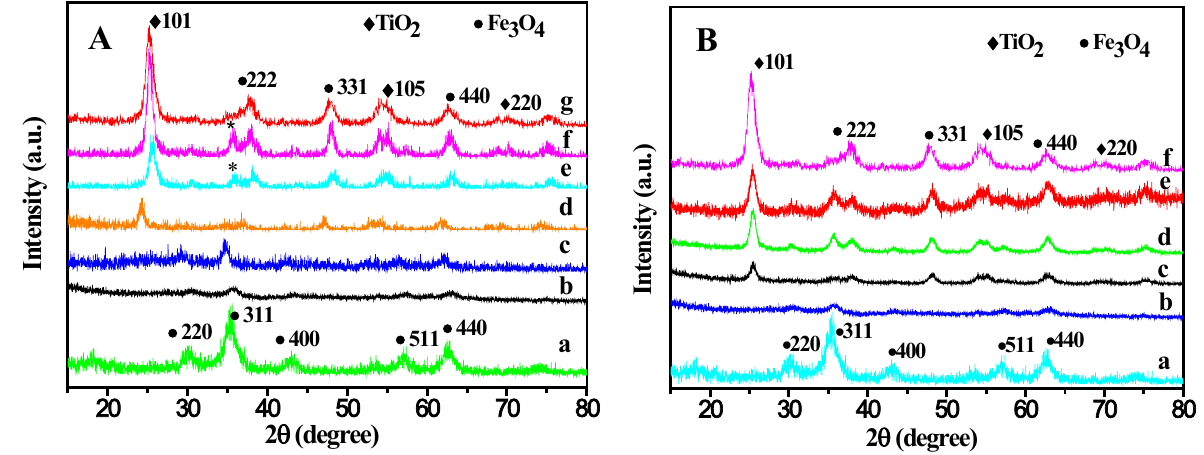
O and Fe O @TiO of prepared 3 4 3 4 2